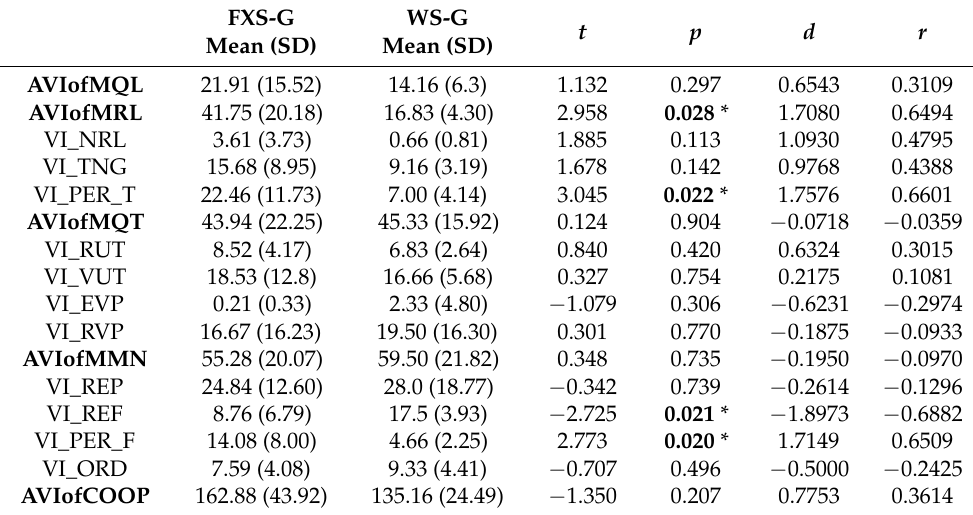
Table 1. Differences in the violation indexes (VIs, AVIs) of the maxims